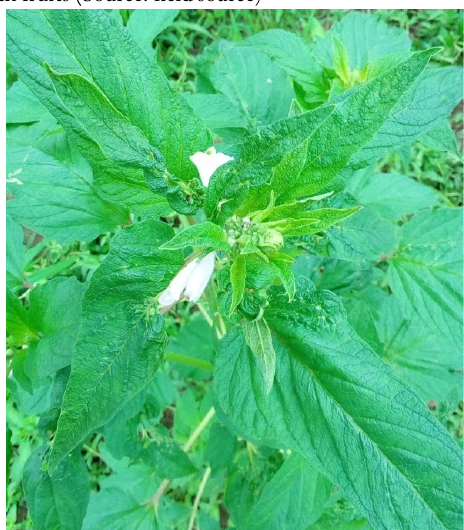
Figure 1. Sesame plant with fruits (Source: field source)